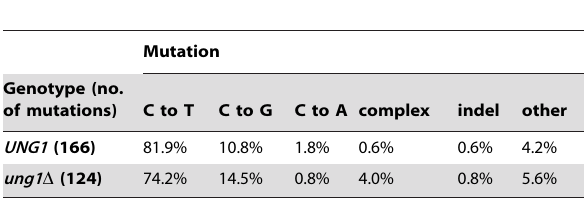
Table 2. Compilation of bisulfite-induced